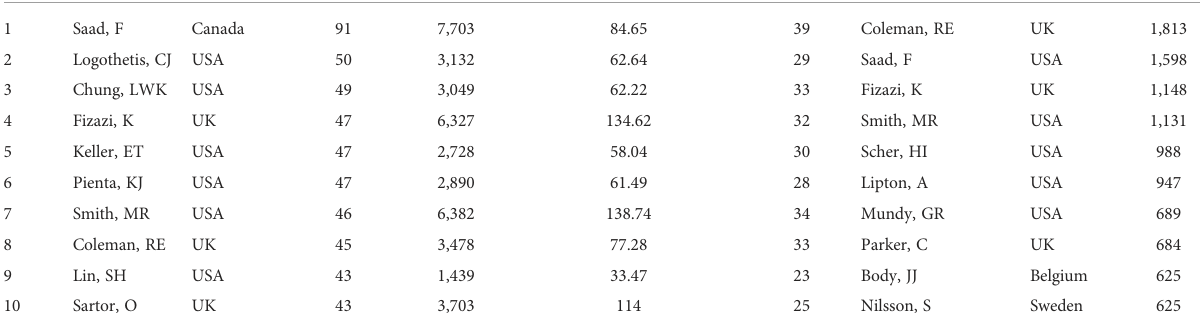
TABLE 3 The 10 most productive authors and the top 10 co-cited authors with the highest number of